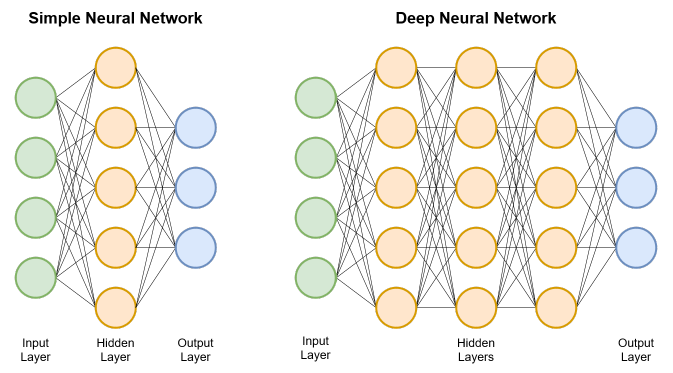
Figure 3. Schematic view of a Neural Network. Deep Neural Networks (DNNs) are just Neural Networks with multiple hidden